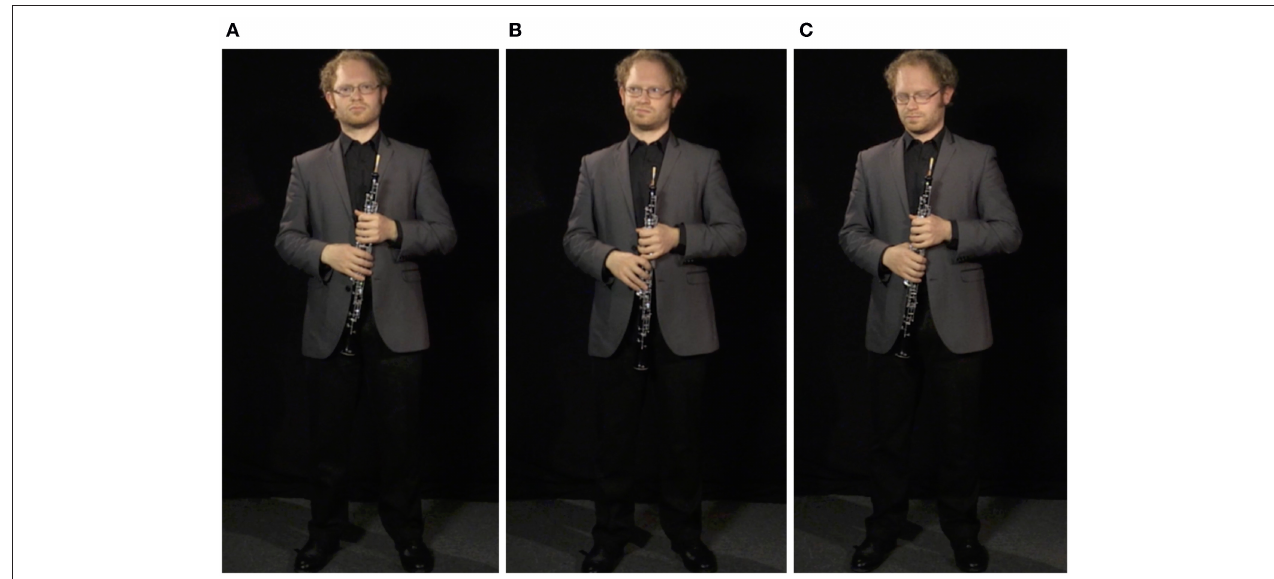
FIGURE 3 | Screenshots of the performer’s three reaction modes. (A) confident . (B) frustrated . (C) distraught . These reactions can also be seen in Supplementary Videos 1–4 .